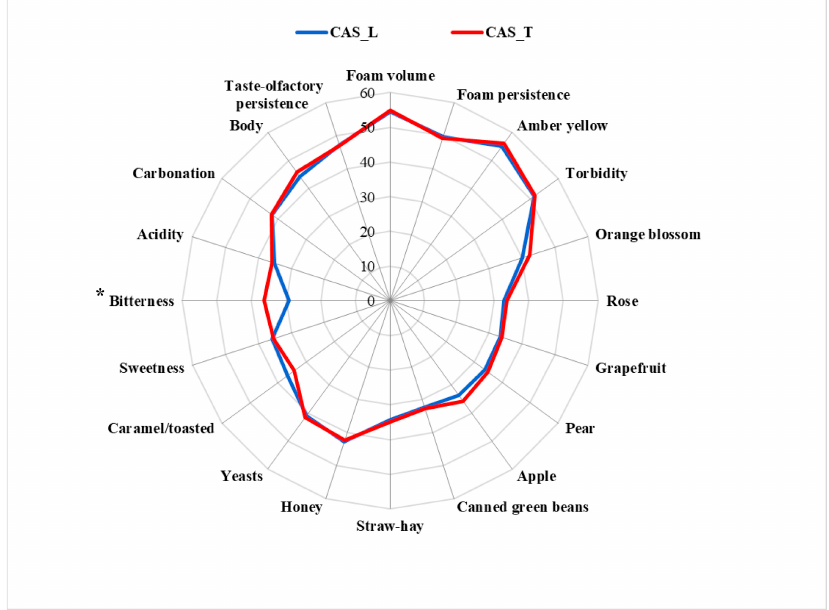
Figure 7. The sensory profiles of the Tuscan and Latin beers (average of three sessions). The asterisk points to the only attribute with a significative difference between the beers.